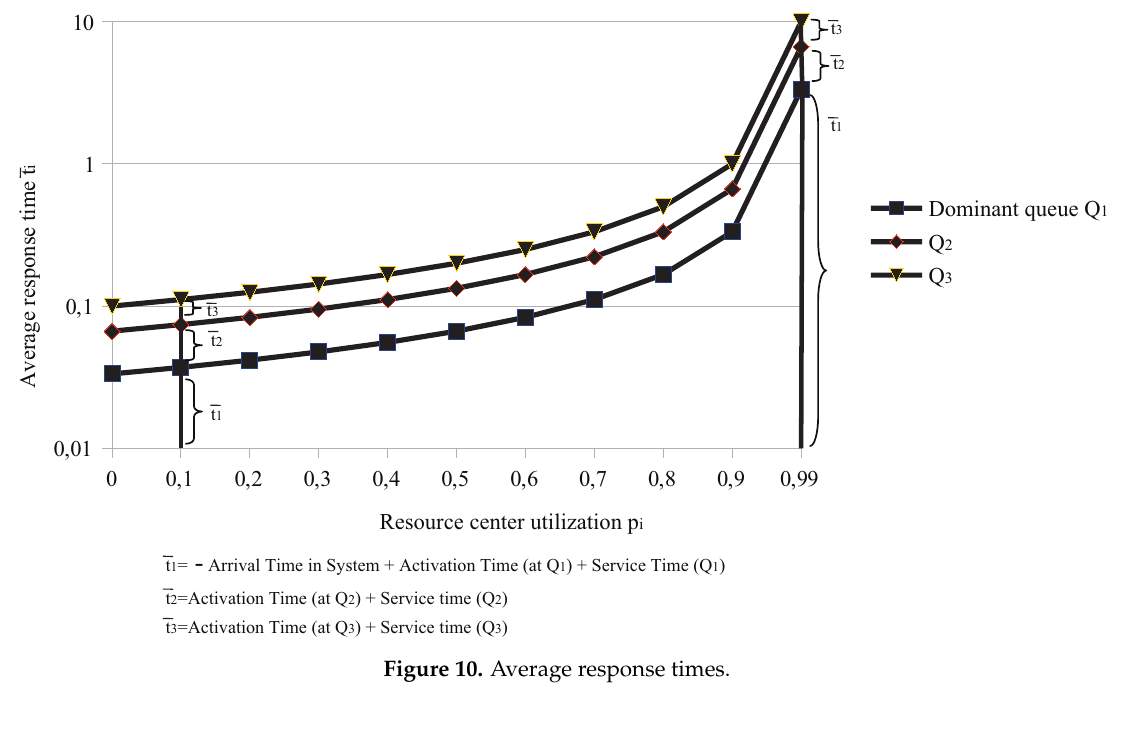
Figure 10. Average response